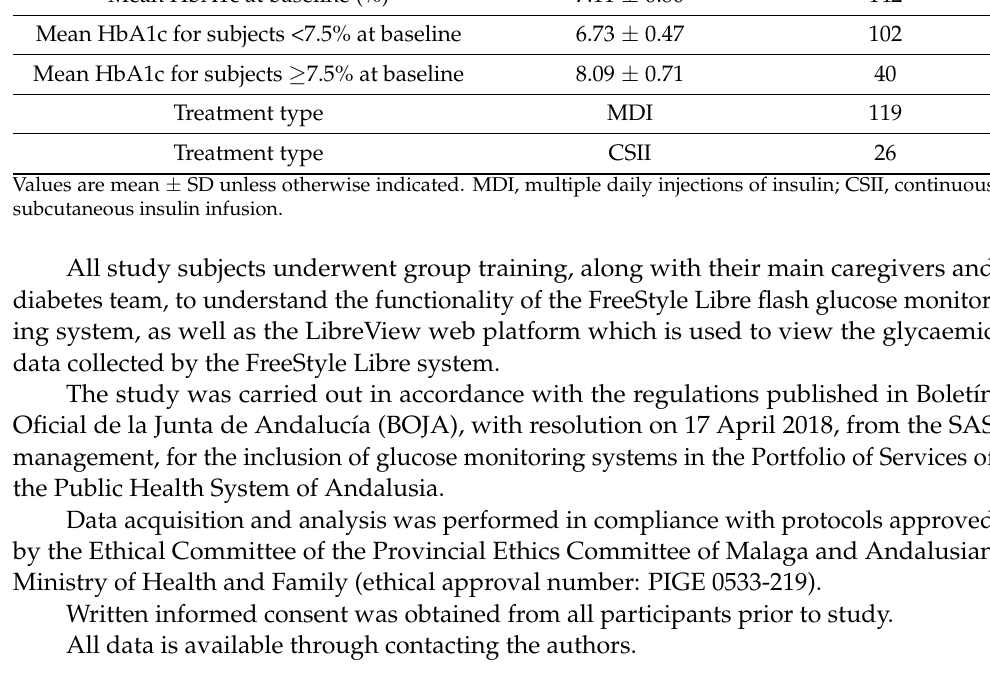
Table 1. Baseline clinical characteristics of the study population. Parameter n Age (years) 11.36 ± 3.06 145 Duration of diabetes (years) 5.2 ± 3.2 145 Mean HbA1c at baseline (%) 7.11 ± 0.80 142 Mean HbA1c for subjects <7.5% at baseline 6.73 ± 0.47 102 Mean HbA1c for subjects ≥ 7.5% at baseline 8.09 ± 0.71 40 Treatment type MDI 119 Treatment type CSII 26 Values are mean ± SD unless otherwise indicated. MDI, multiple daily injections of insulin; CSII, continuous subcutaneous insulin